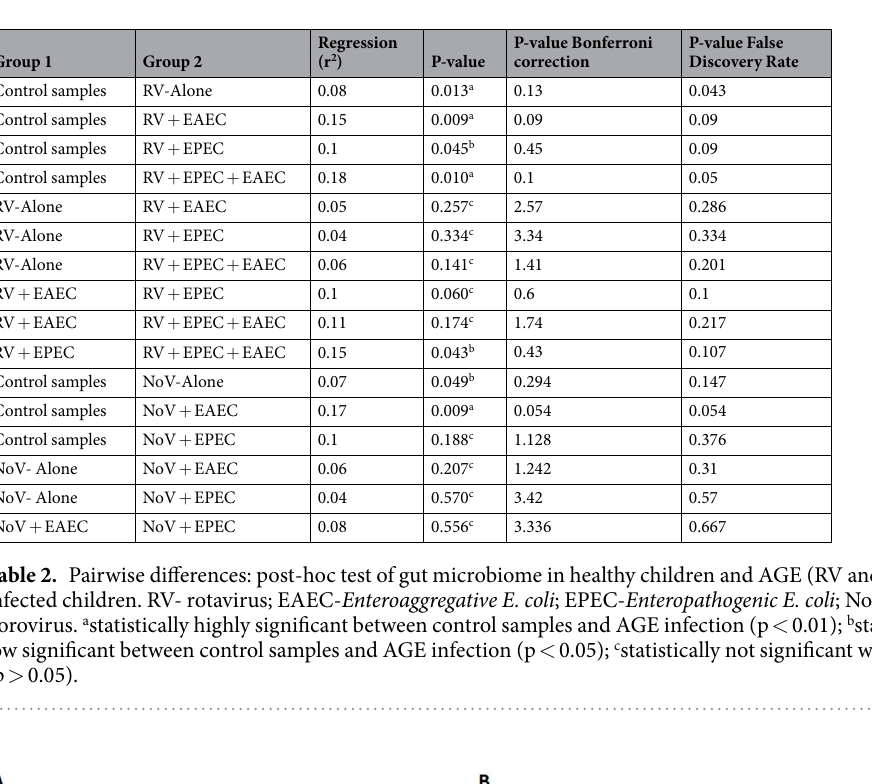
Blautia , Parabacteroides faecis , Fusobacterium , Gemella , Moraxella and Pullicaecorum [Supplementary Data S1- Fig. 3(A)]. Only five OTUs were significantly abundant in the RV-alone infected children group ( p adjusted < 0.05),